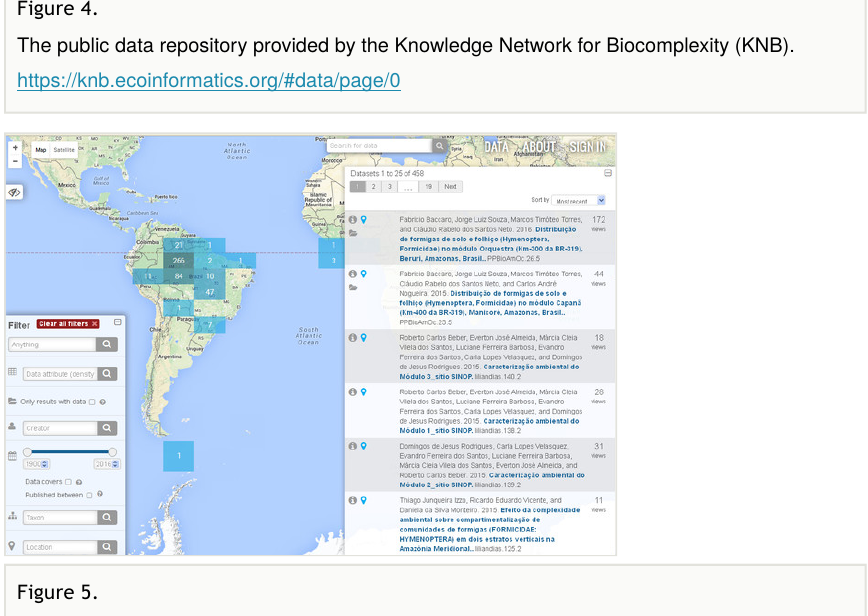
PPBio has installed a Metacat instance for their researchers to upload and make publicly available the results of work related to biodiversity in the Western Amazon.